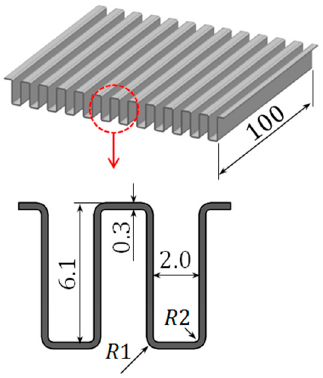
Figure 1. Rectangular fins of the plate fin heat exchanger (unit: mm).